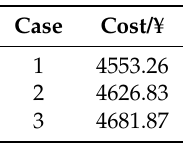
Table 7. Total electricity